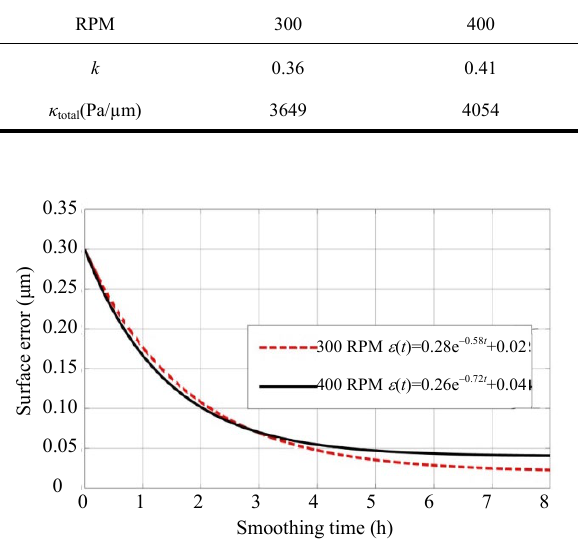
Fig. 17 Surface error ε ini vs . smoothing time t for 300-RPM and 400-RPM tool speed V .